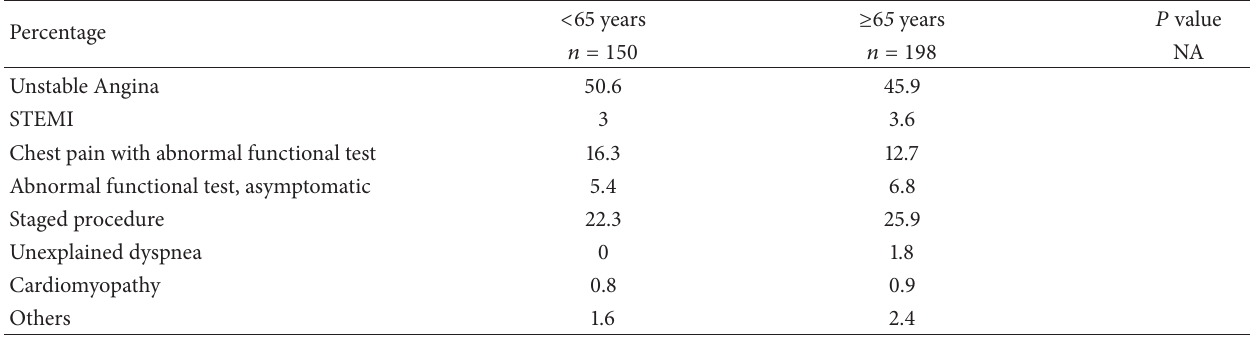
Table 3: Reasons for the index